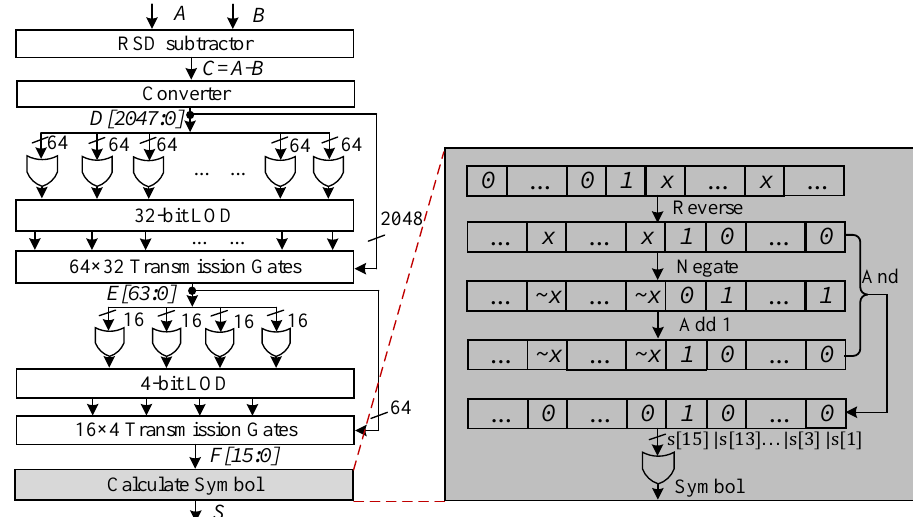
Figure 9: The architecture of compare